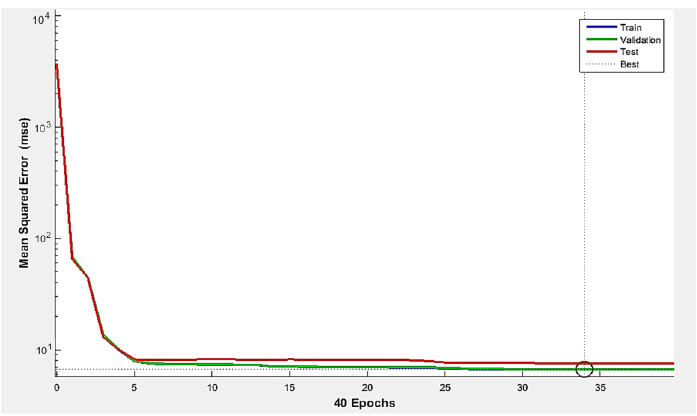
Figure 8. Number of iterations (epochs) versus mean square error (MSE). Table 4. Neural network